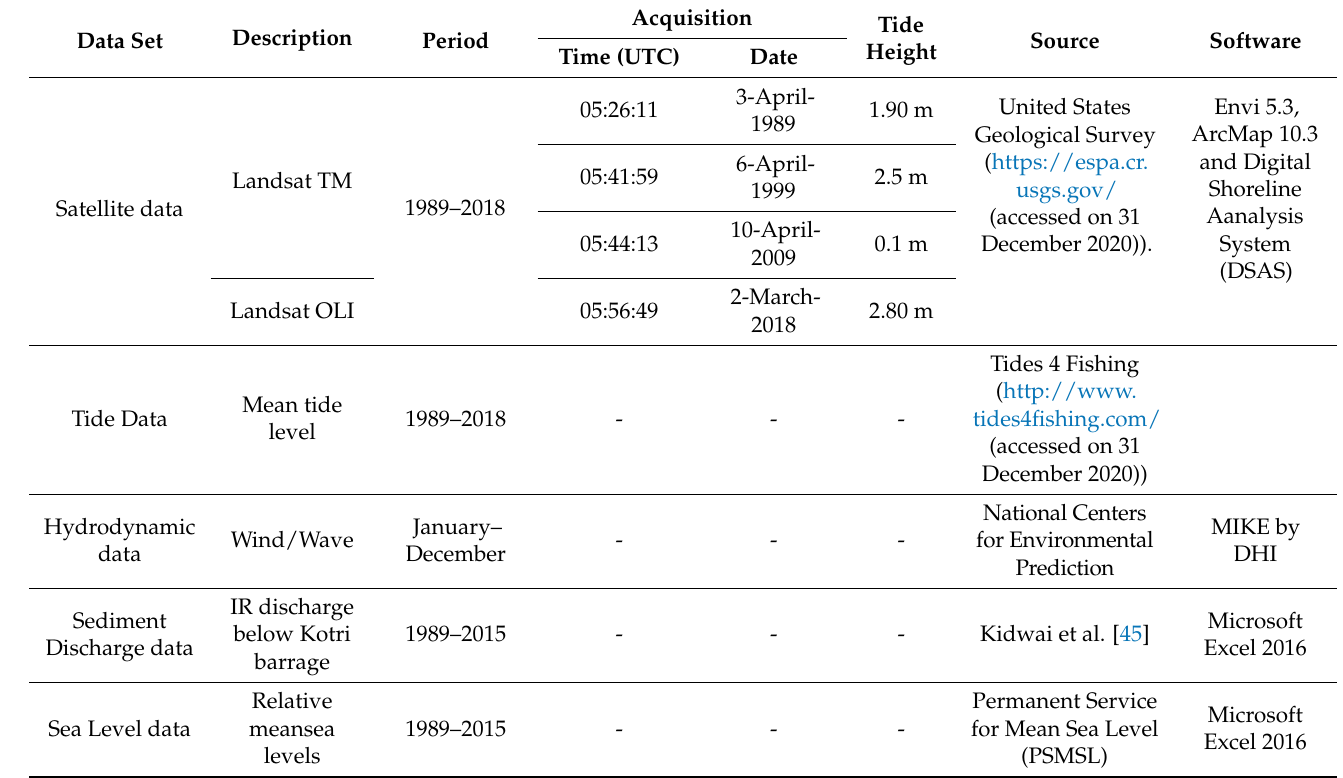
Table 2. Details of data sets used along with necessary meta